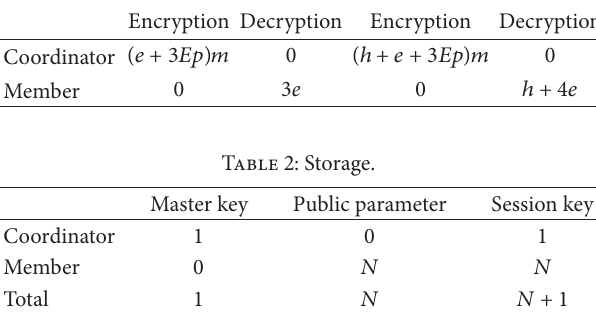
Table 1: Comparison of computational load. EGK